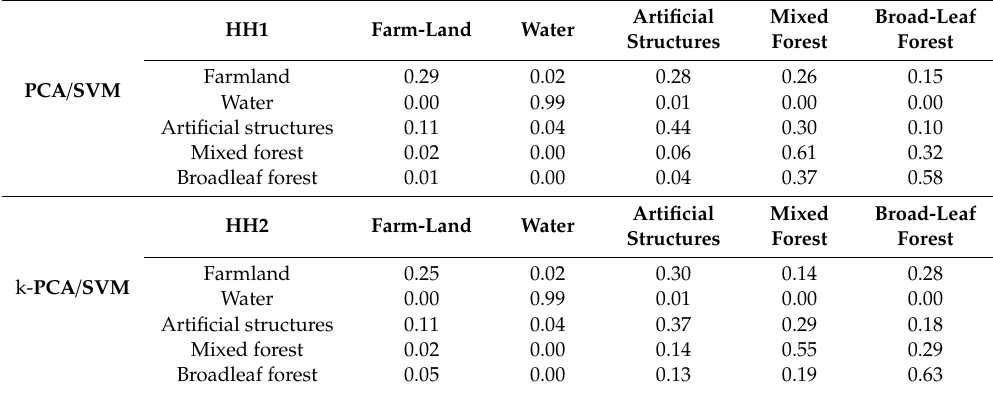
Table 5. Confusion matrix of k-PCA / SVM classification scheme over